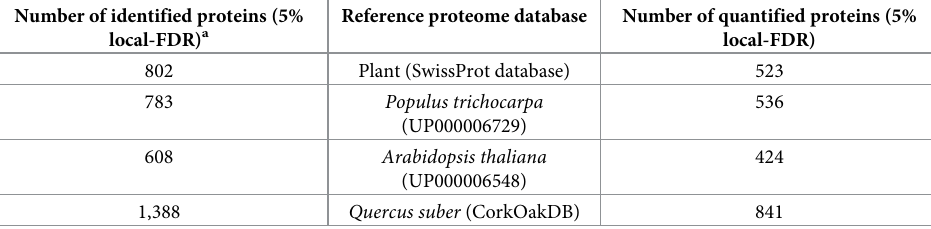
Table 1. Number of proteins identified and